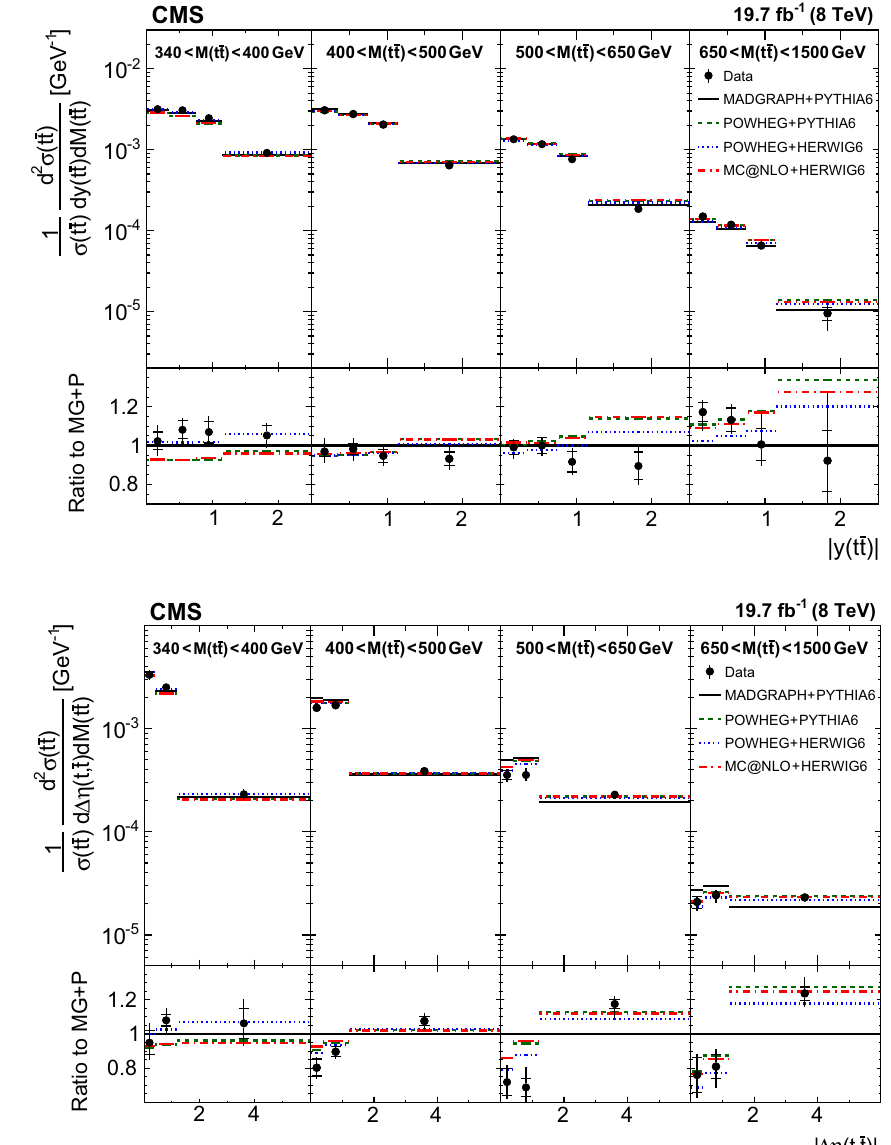
Fig. 4 Comparison of the measured normalized tt double-differential cross section as a function of | y ( tt ) | in different of M ( tt ) ranges to MC predictions. Details can be found in the caption of Fig. 2